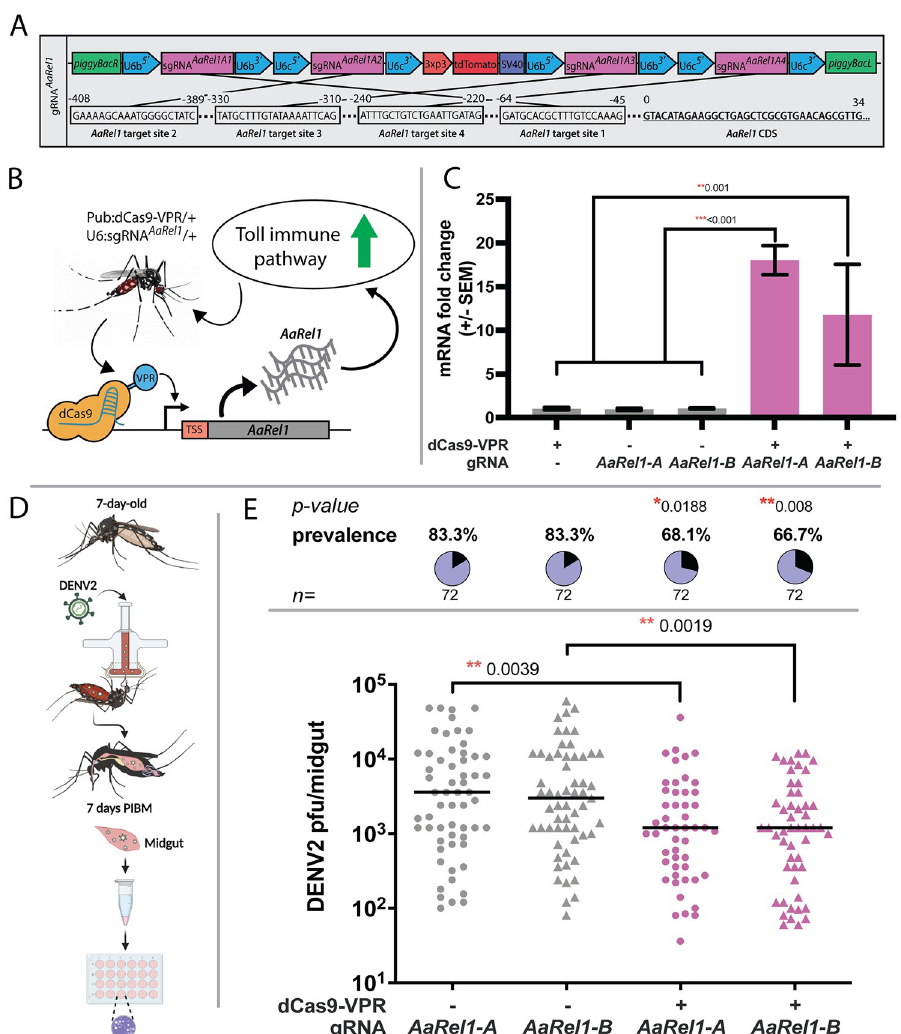
Fig 4. CRISPRa mediated transactivation of Toll immune pathway, RT-PCR validation of AaRel1 overexpression and suppression of viral infection. A) Schematic representation of the sgRNA AaRel1 construct used to create the U6: sgRNA- AaRel1 lines. B) Schematic representation of the transgenic line expressing Pub:dCas9-VPR and the U6: sgRNA targeting the promoter region of AaRel1 gene and inducing the activation of the Toll immune pathway. C) Quantification by qPCR of AaRel1 gene expression in controls and transactivated lines. A one-way ANOVA and Tukey’s multiple-comparison test was performed between transheterozygous crosses and controls. � P < 0.05, �� P < 0.01, ��� P < 0.001 D) Antiviral effect of CRISPRa mediated transactivation of AaRel1 in the transheterozygous progeny. sgRNA- AaRel1 line A and B (sgRNA- AaRel1 -A and sgRNA- AaRel1 -B, or named as U6:sgRNA rel1-A and U6: sgRNA rel1-B ) and transheterozygotes (dCas9-VPR/sgRNA- AaRel1 -A and dCas9-VPR/sgRNA- AaRel1 -B or named as dCas9-VPR/U6-sgRNA rel1-A and dCas9-VPR/U6-sgRNA rel1-B ) were orally infected with DENV2 as illustrated. E) The viral infection titers and infection prevalence of DENV2 were measured after midgut infection at 7 days post-infectious blood meal (PIBM). Plaque assays were used to determine viral titers and infection prevalence in individual mosquitoes with each dot representing the viral load from one midgut, and pie-chart indicating the infection prevalence. at At least three replicates were pooled for the statistical analyses. Horizontal black lines indicate the median of the viral loads. Considering the non-normal distribution of viral titers, median is used to describe central tendency and non-parametric Mann-Whitney test was used to compare median viral titers and Fisher’s exact test to compare infection prevalence. � P < 0.05, �� P < 0.01, n : total numbers of mosquitoes used in the assays. sgRNA- AaRel1 lines were used as controls. Created with